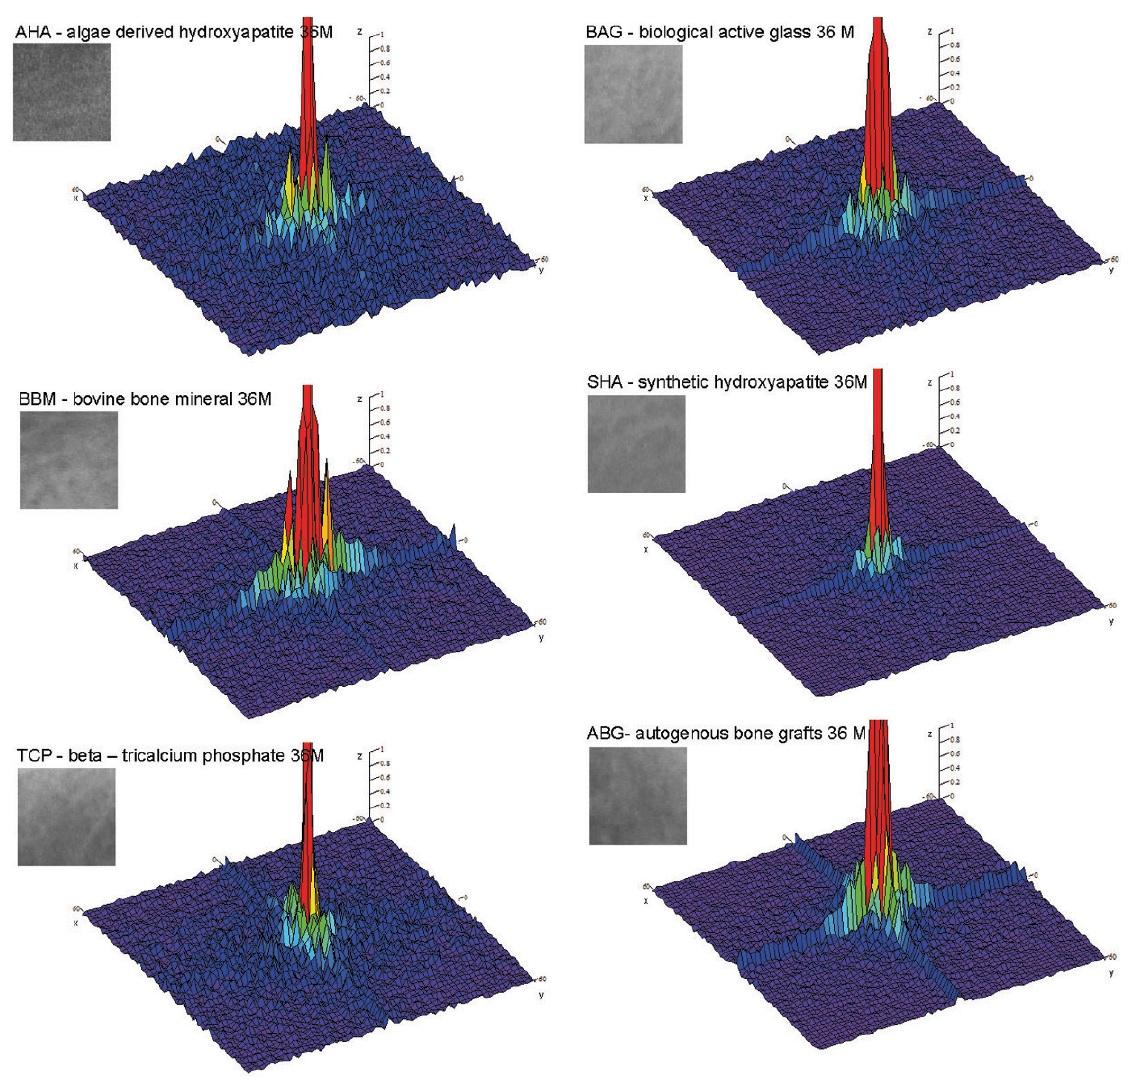
Figure 1d. Results of Fourier Transformation: 3 dimension presentation of amplitude distributions the Fourier Transformation of analysed images; (axes: x,y – spatial frequencies, z – amplitude). Abbreviation: 36M – thirty six months after